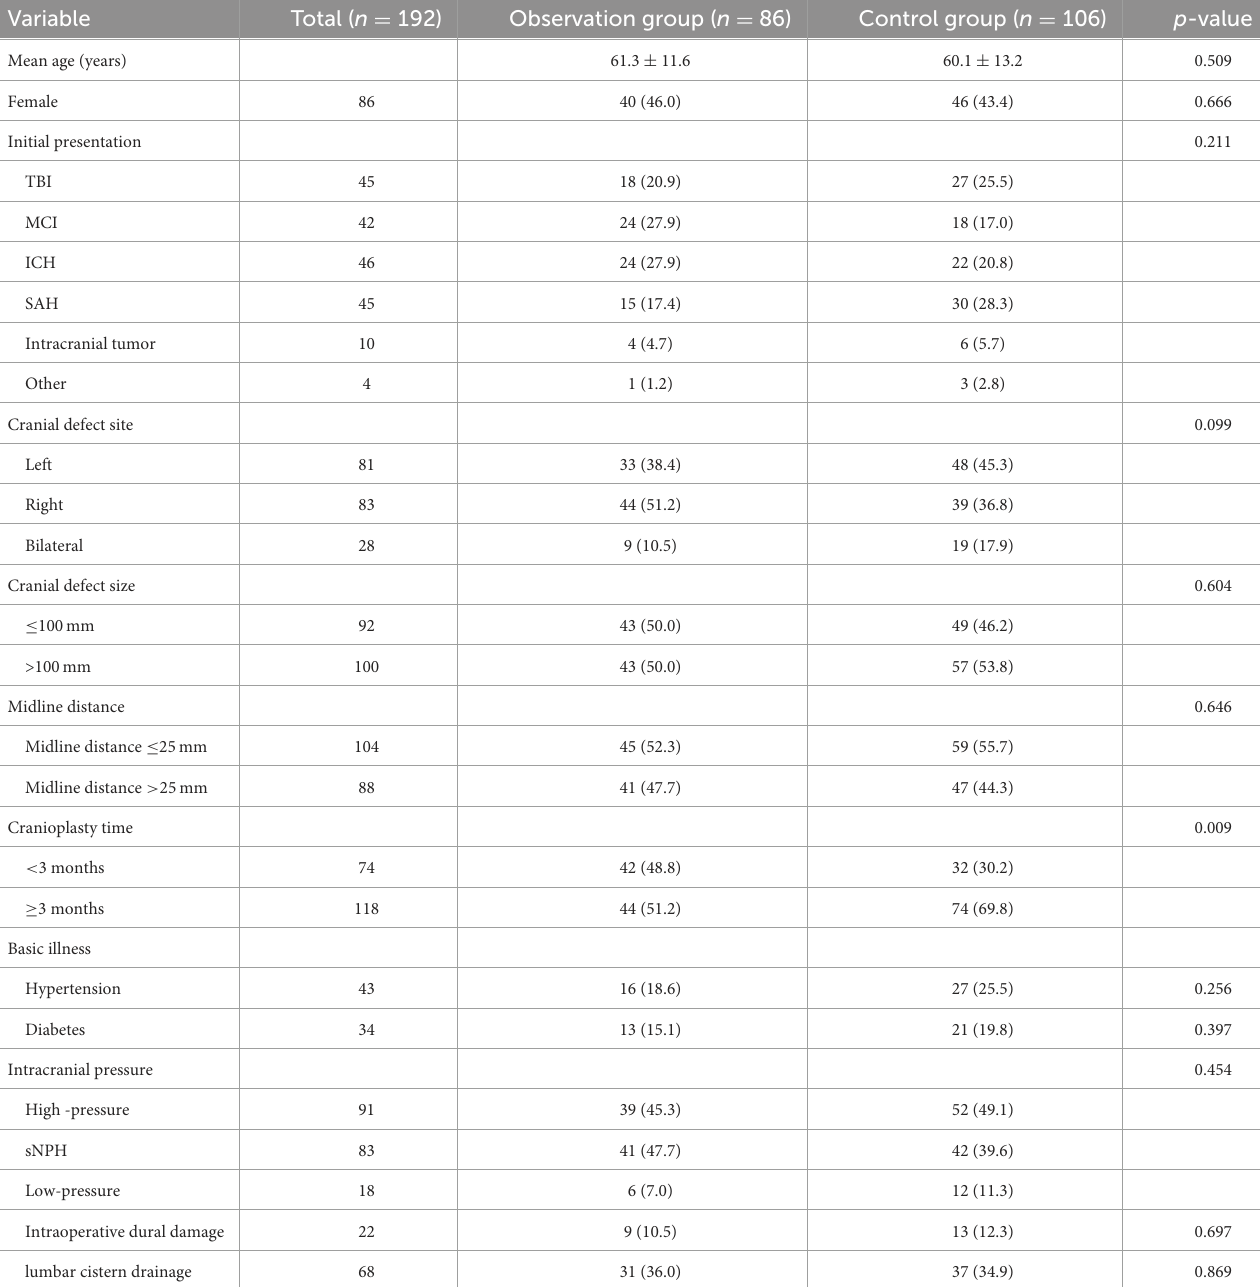
TABLE 1 Comparison of baseline characteristics in patients with observation and control